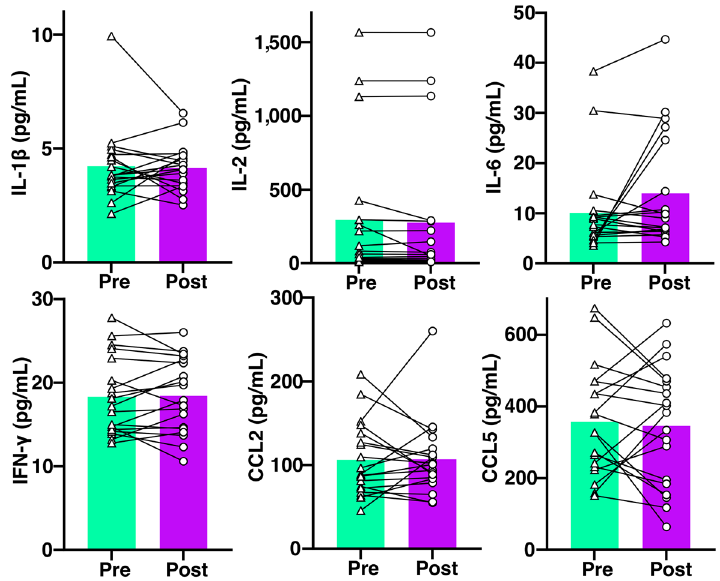
Figure 2. Difference of cytokine levels between baseline and after a seizure. Among the patients who had a seizure during the video EEG monitoring, the change of the cytokine levels between baseline and post-seizure cytokine was analyzed. The IL-1β, IL-2, IL-6, IFN-γ, CCL2, and CCL5 were all not significantly changed before the